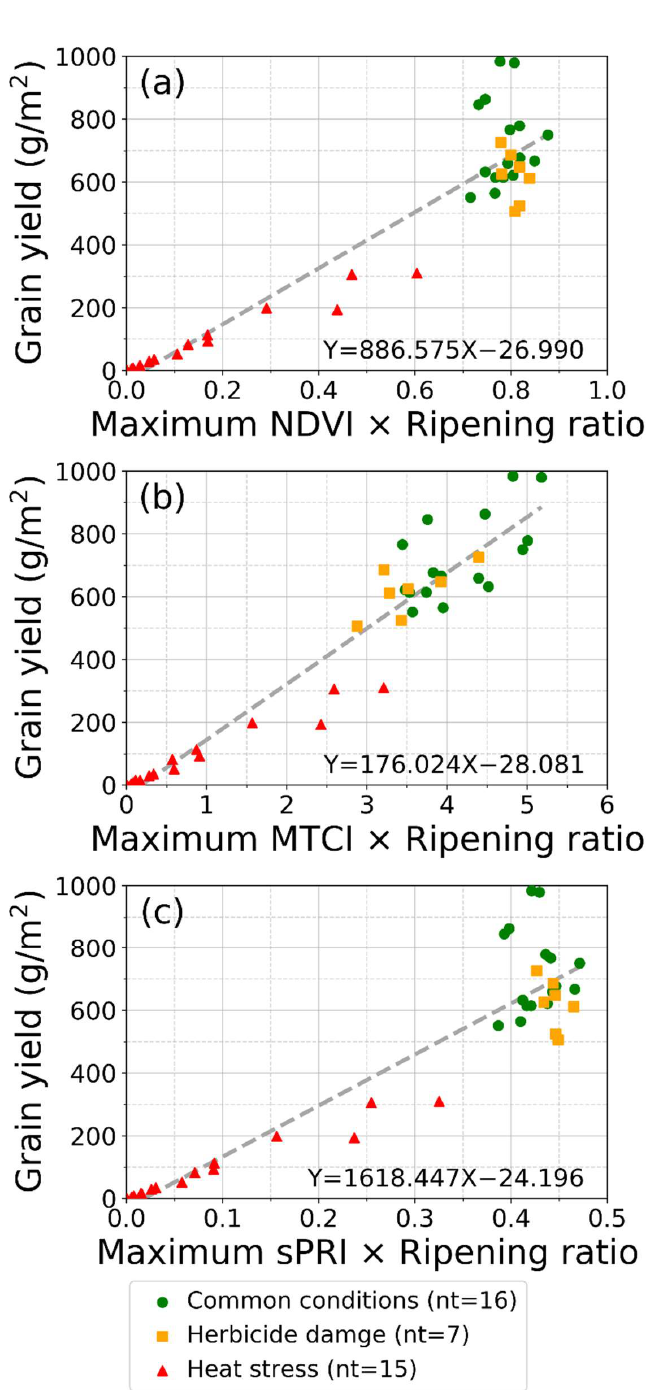
Figure 11. Relationship between maximum vegetation index value during cultivation period × ripening ratio and grain yield.